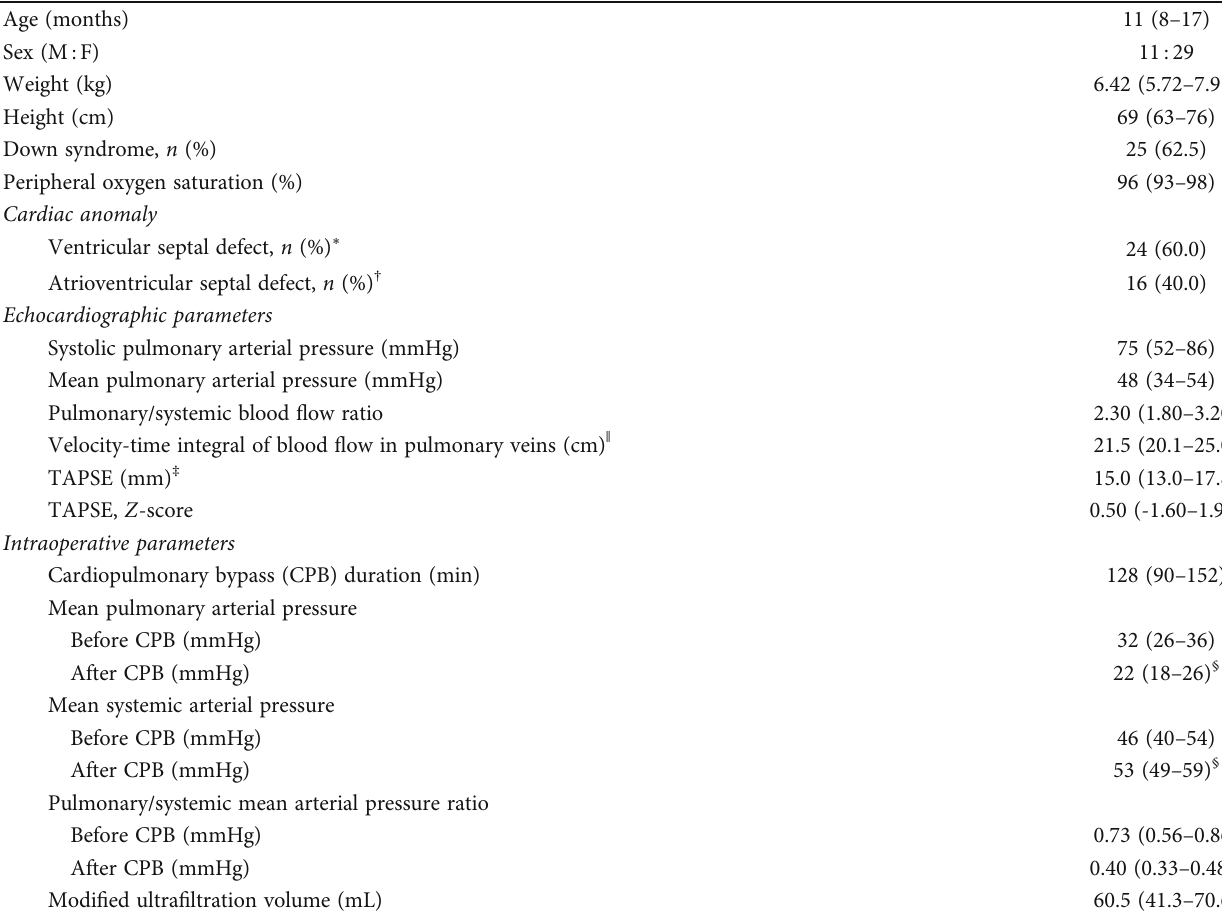
Table 1: Preoperative and intraoperative data of 40